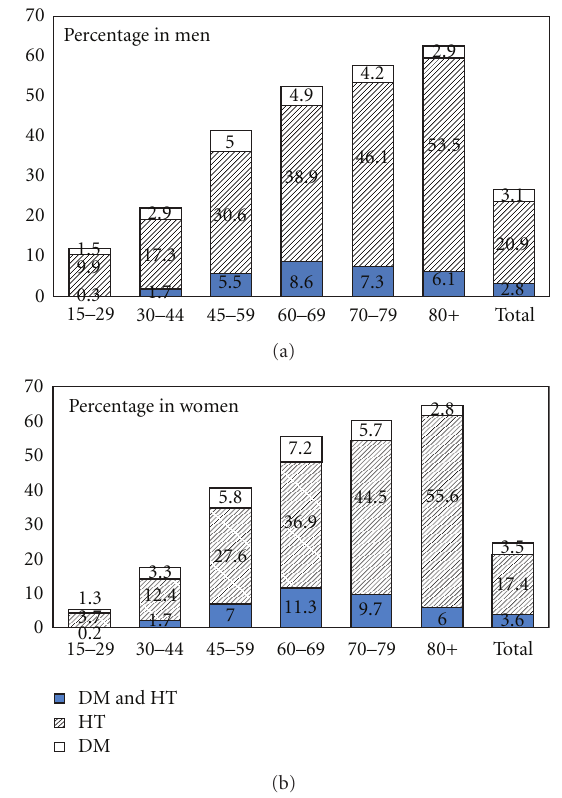
Figure 1: Prevalence of diabetes, hypertension, and coexistence of both conditions in Thai population aged ≥ 15 years by age